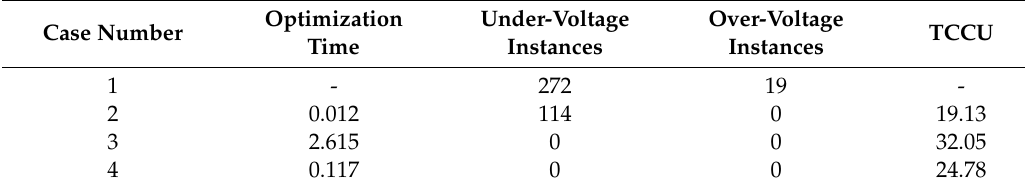
Table 2. Simulation results before on-load tap changer (OLTC) operation of the four cases. TCCU–total capacity of CLS